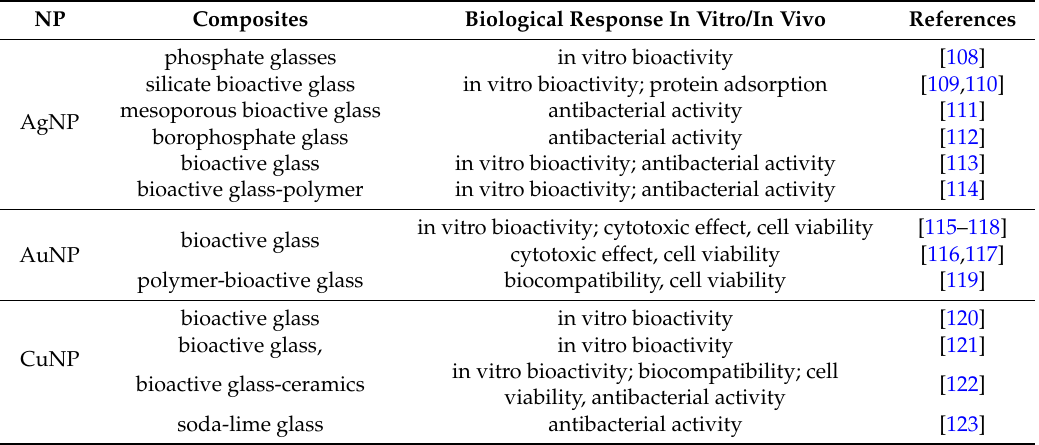
Table 1. Effect of metallic nanoparticles (NPs) on organism: summary of literature